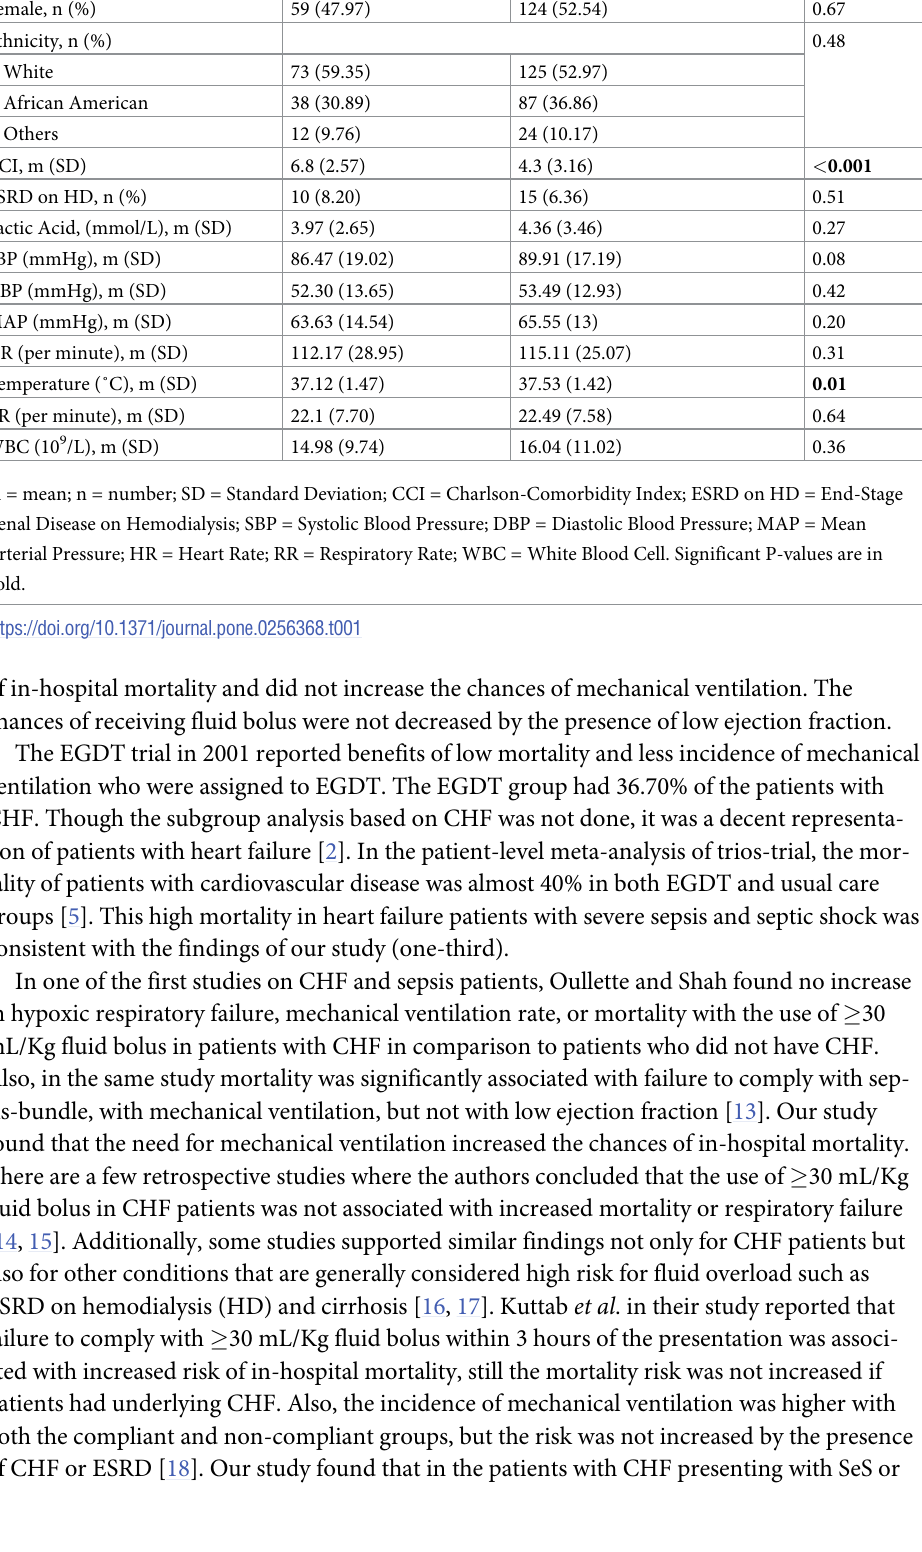
Table 1. Comparison of baseline characteristics in the primary groups that received � 30 mL/Kg fluid bolus. Case (CHF), n = 123 Control (non-CHF), n = 236